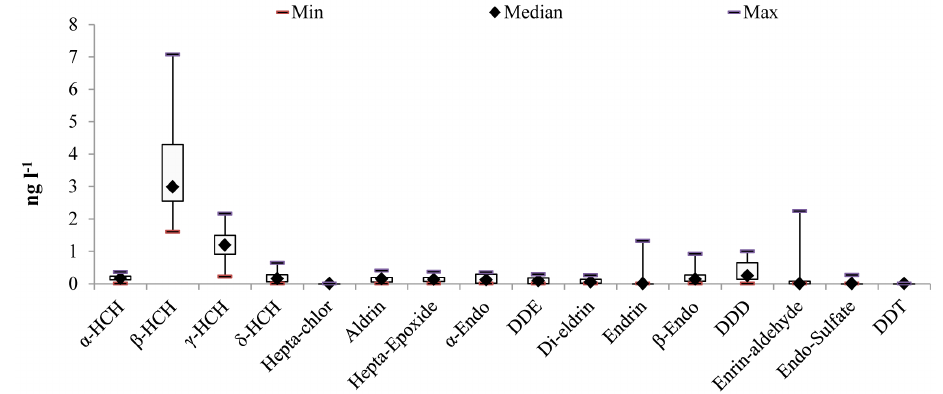
Figure 3. Organochlorine pesticide residues (ngL − 1 ) in river water samples of Uttarakhand (UK) area.